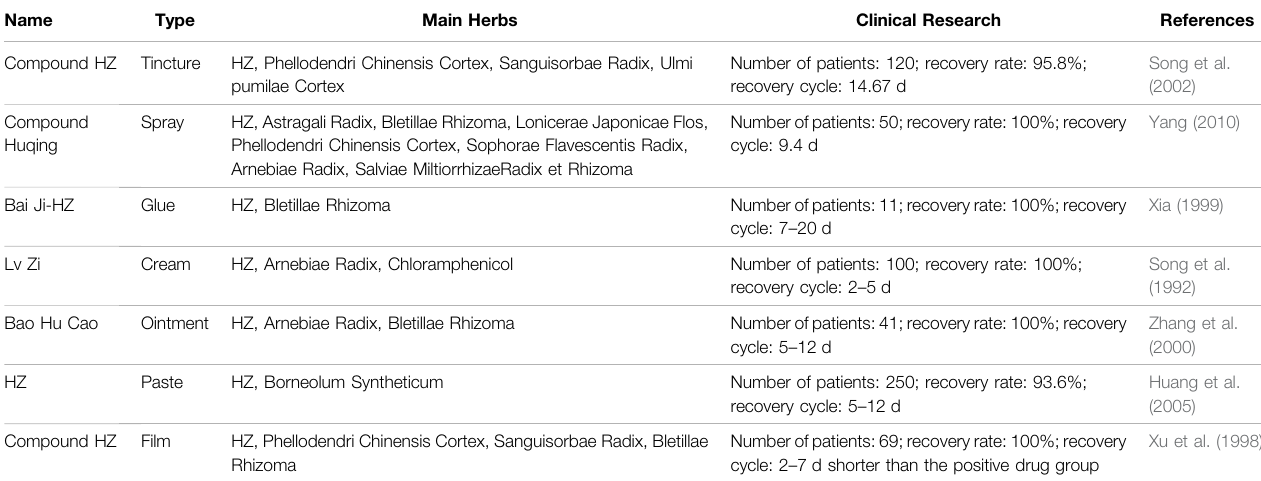
TABLE 4 | Representative preparations of HZ in treatment of